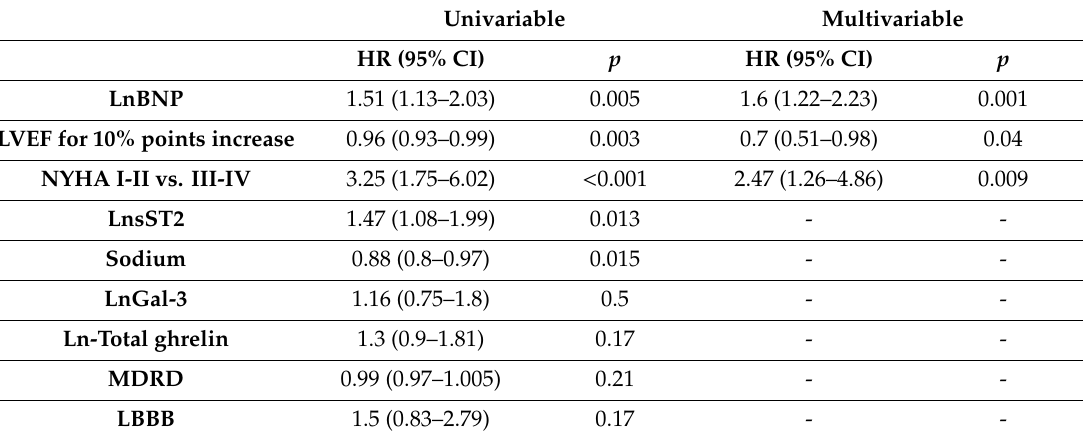
Table 7. Predictors of mortality / heart transplantation at multivariable Cox proportional hazards regression